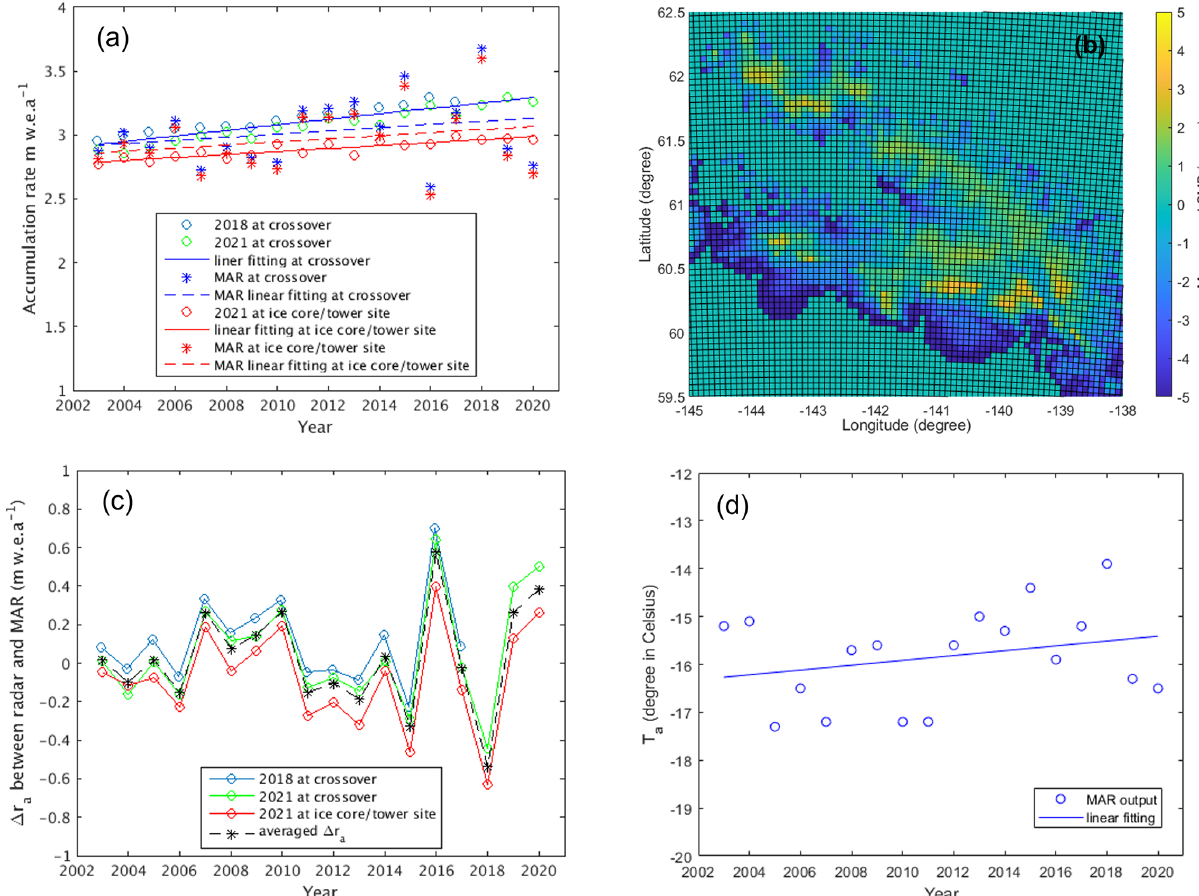
Figure 9. (a) Estimated annual accumulation rates. (b) MAR map of mean annual SMB over Alaskan glaciers between 2016–2021. (c) Dif- ferences between r a from radar data and SMB from MAR. (d) Averaged annual temperature from